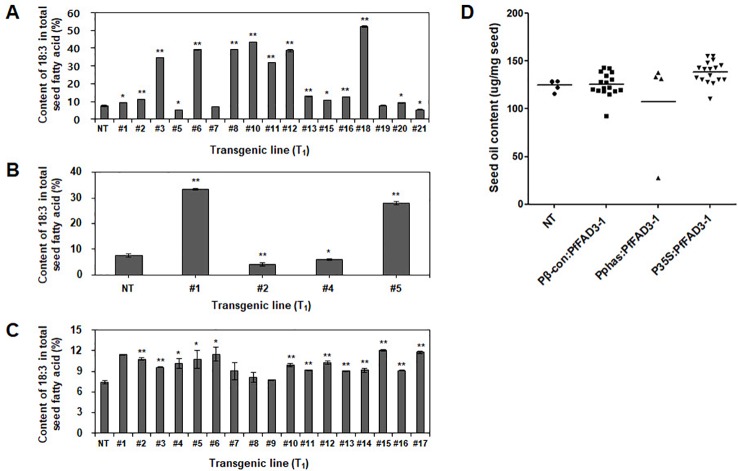
Content of α-linolenic acid (ALA) and seed oil in transgenic soybean seeds (T1). Content of ALA in Pβ-con:PfFAD3-1
(A), Pphas : PfFAD3-1
(B), and P35S:PfFAD3-1
(C) was analyzed using gas chromatography. (D) Seed oil content analysis of three PfFAD3-1 transgenic soybeans. NT, non-transgenic plant; #1–#21 (part A), T1 seeds of Pβ-con:PfFAD3-1 transgenic lines; #1–#5 (part B), T1 seeds of Pphas : PfFAD3-1 transgenic lines; #1–#17 (part C), T1 seeds of P35S:PfFAD3-1 transgenic lines. In parts A–C, error bars indicate the means ± standard deviations; asterisks indicate significant changes compared to NT values (* = p < 0.05; ** = p < 0.01). In part D, dots represent the seed oil content from each line (triplicate measurements); bars indicate mean values.